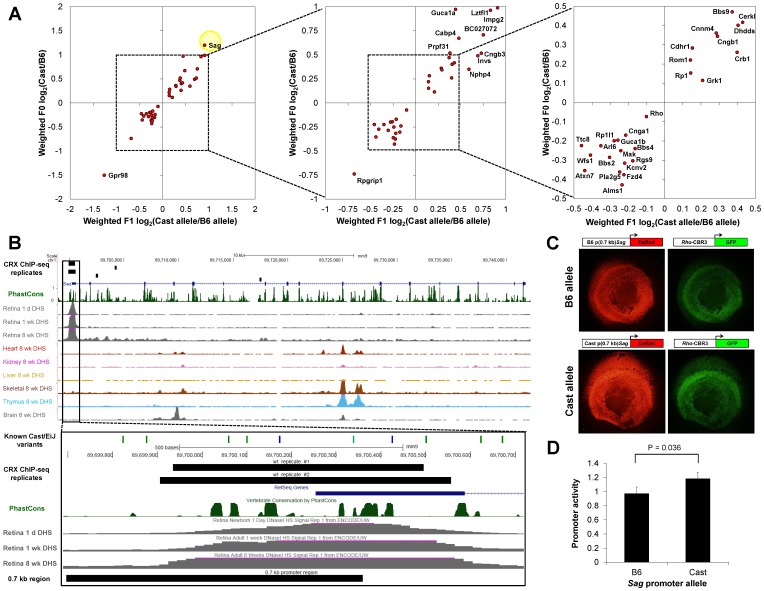

Cis-effect genes associated with retinal disease and photoreceptor CREs.(A) Cis-effect genes associated with CRX ChIP-seq peaks were matched against the RetNet database of retinal disease genes. The yellow circle highlights Sag. (B) Sag locus, mm9. Top: Screenshot from UCSC Genome Browser [77]. DNaseI hypersensitivity site (DHS) signals are from ENCODE data [8]. Bottom: Enlargement of boxed region. The 0.7 kb promoter region is depicted here. Locations of known Cast/EiJ variants [19] are depicted as green tic marks (SNPs) or blue tic marks (indels). (C) Retinal explant electroporation was used to assay the activity of the 0.7 kb Sag promoter region of B6 and Cast alleles. Representative images are shown here for the B6 (top) and Cast (bottom) 0.7 kb Sag promoter constructs driving DsRed expression. Rho-CBR3-eGFP served as the loading control. (D) Quantification of the cis-regulatory activity measured by the explant electroporation assay. Error bar represents SEM. P-value was calculated with one-tailed Wilcoxon rank-sum test.